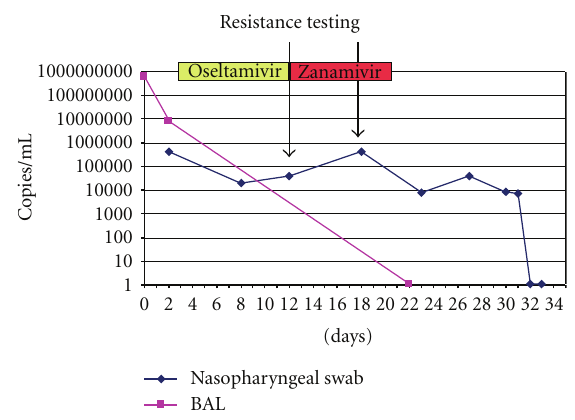
Figure 2: Modifications of the viral charge during treatment with oral Oseltamivir and parenteral